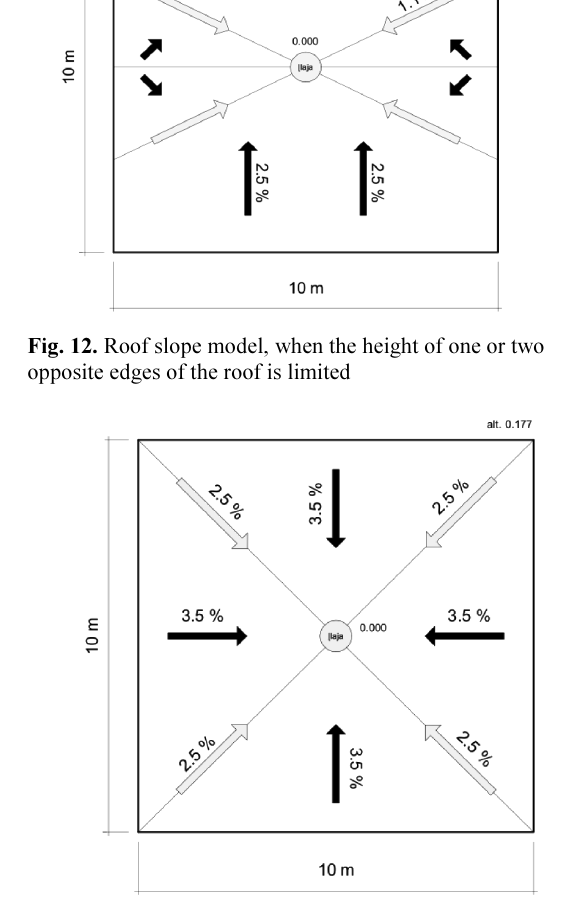
Fig. 13. The model of roof slopes and the slope size,